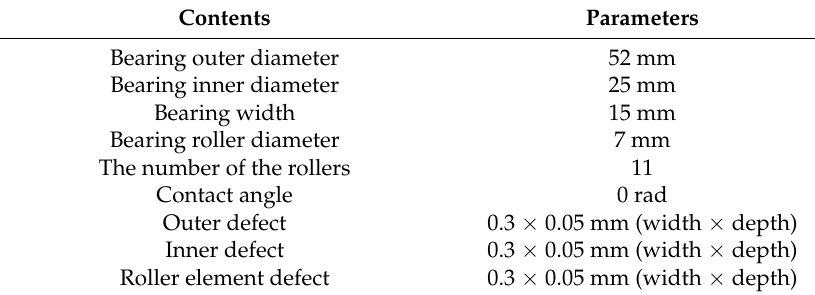
Table 1. Bearing parameters for verification.